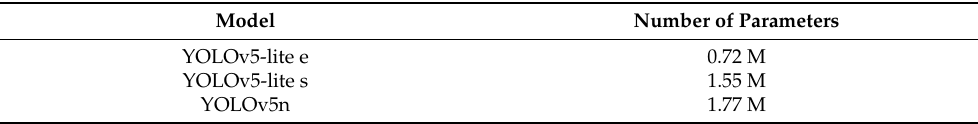
Table 3. Charactersitics of different edge suitable yolo